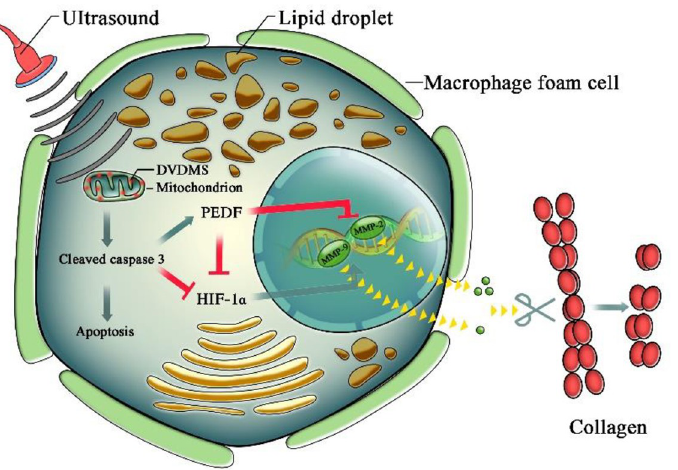
Fig 6. Illustration of sinoporphyrin sodium-mediated sonodynamic therapy (DVDMS-SDT) inhibition of collagen degradation in advanced atherosclerotic plaque. DVDMS-SDT induces mitochondrial-caspase apoptosis in macrophage foam cells. Meanwhile, activated caspase 3 increases PEDF expression, and caspase 3 and PEDF jointly inhibit HIF-1 α expression, thereby suppressing the expression of MMP-2 and MMP-9 and resulting in the inhibition of collagen